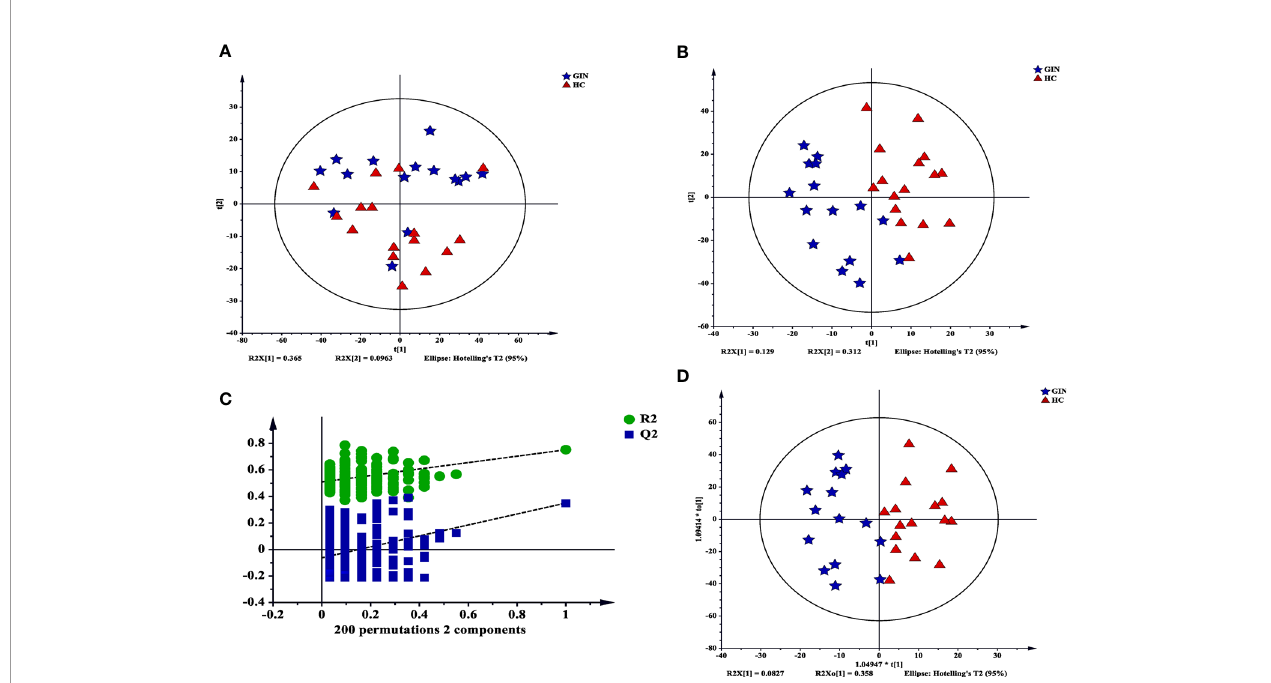
FIGURE 6 | Multivariate statistical analysis for GC-MS based on metabolic pro fi ling. (A) a PCA score plot data from the healthy control group (red) the versus the gingivitis group (blue); (B) a PLS-DA scores plot data fron the healthy control group (red) versus the gingivitis group (blue); (C) internal cross validation plot with a permutation test repeated 200 times; (D) OPLS-DA scores plot data from the healthy control group (red) versus the gingivitis group (blue).